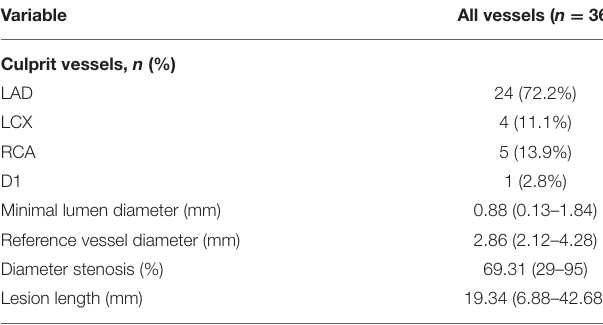
TABLE 1 | Baseline characteristics of the patient population. TABLE 2 | Angiographic characteristics of the culprit